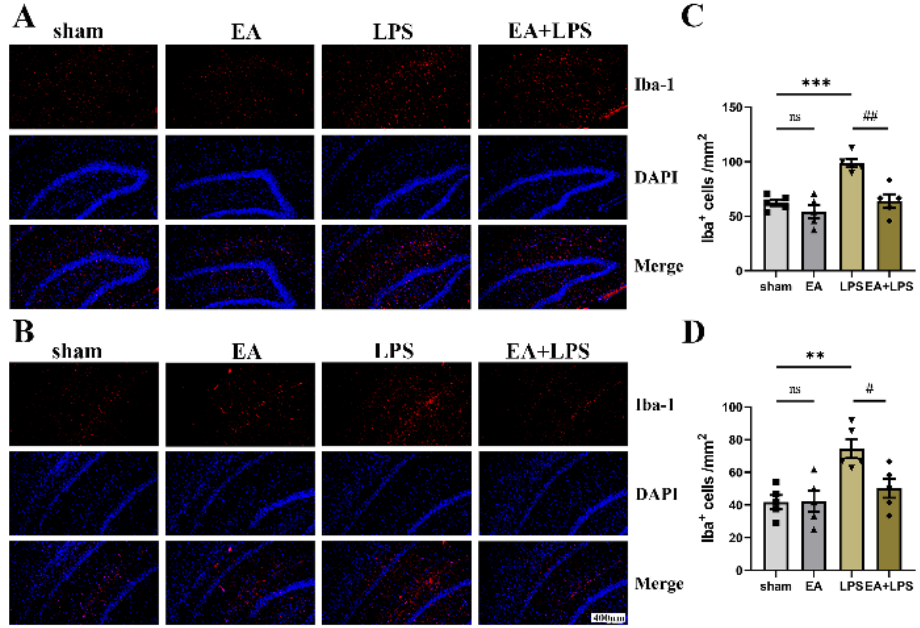
Figure 5. EA suppressed the expression level of Iba-1 and GFAP in the hippocampus: n = 5 per group. ( A ) Representative blots of Iba-1. ( B ) Representative blots of GFAP. ( C ) Quantification of the expression level of Iba-1. ( D ) Quantification of the expression level of GFAP. Data are presented as means ± SEM. Compared with the sham group, *** p < 0.001, **** p < 0.0001; compared with the LPS group, ## p < 0.01. , , , : Represents the individual value of the rats in each group. Abbrevia- tions: GFAP, glial fibrillary acidic protein; Iba-1, ionized calcium-binding adapter molecule 1; EA, electroacupuncture; LPS, lipopolysaccharide; ns, no significant difference.